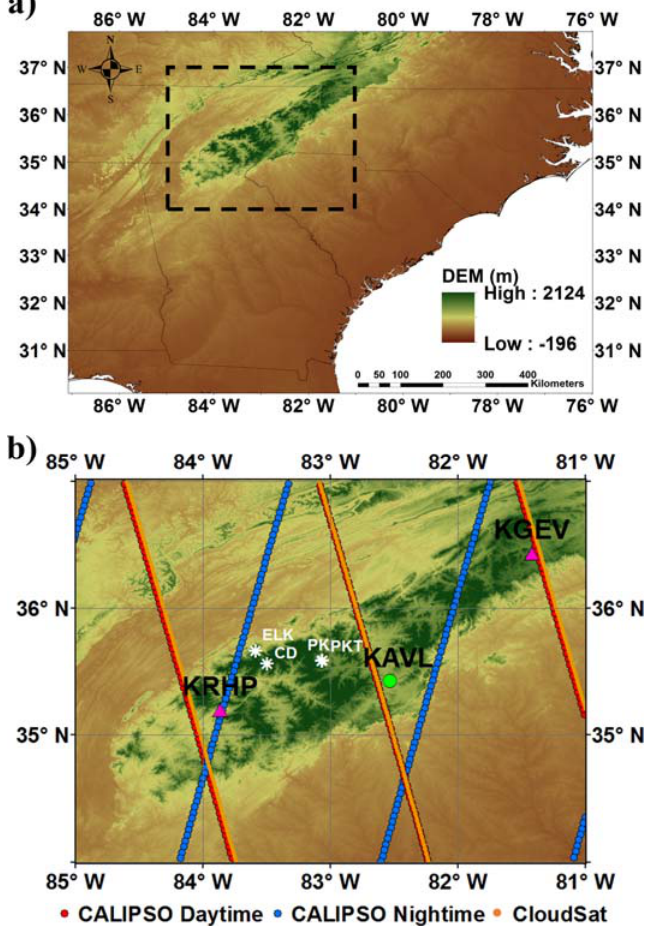
Figure 1. ( a ) Region of study (in the black box) in context of southeastern United States map; ( b ) Overview of Cloud-Aerosol Lidar and Infrared Pathfinder Satellite Observations (CALIPSO) and CloudSat overpasses over the study region. Note the CALIPSO daytime tracks are represented by red dotted lines and the nighttime ones by the blue dotted lines. The CloudSat daytime tracks are indicated by orange lines. From left to right, the three ground ceilometer stations are located at Andrews Murphey Airport (KRHP, marked by the pink triangle), Asheville Airport (KAVL, marked by the green circle), and Jefferson Ashe County Airport (KGEV, marked by the pink triangle). White asterisks denote the locations of four ground fog collectors at Elkmont (ELK), Clingmans Dome (CD), Purchase Knob (PK), and Purchase Knob Tower (PKT).